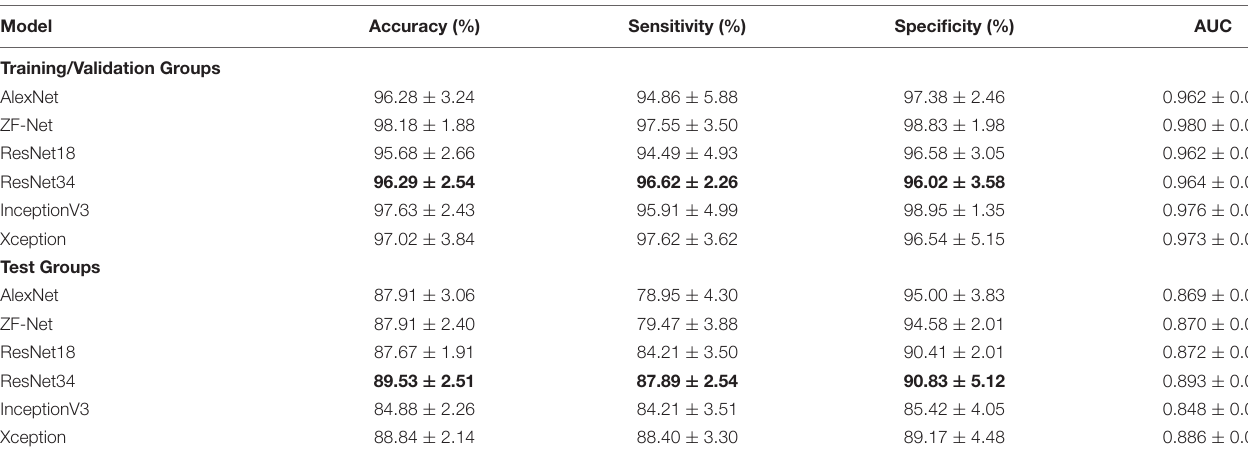
TABLE 2 | Classification performance of different DL models in the pre-training step.